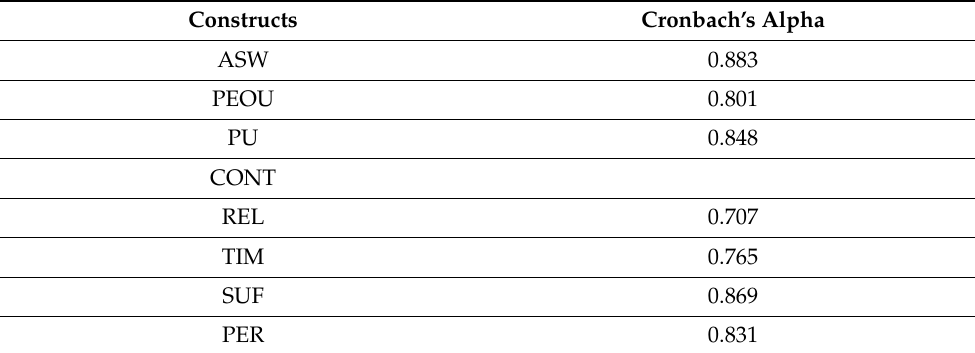
Table 4. Cronbach’s alpha values for the pilot study (Cronbach’s Alpha ≥